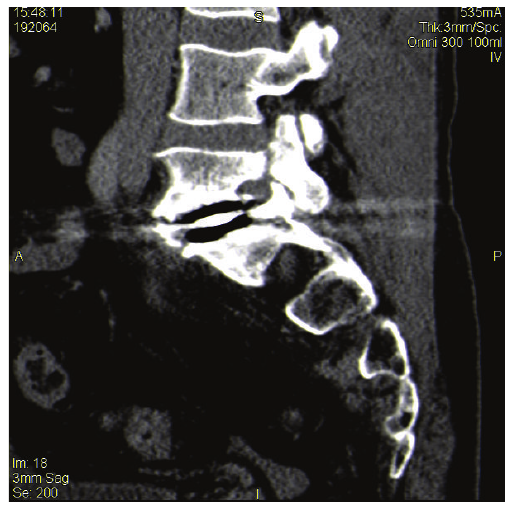
Figure 4: Sagittal view of L5 pedicle fracture.